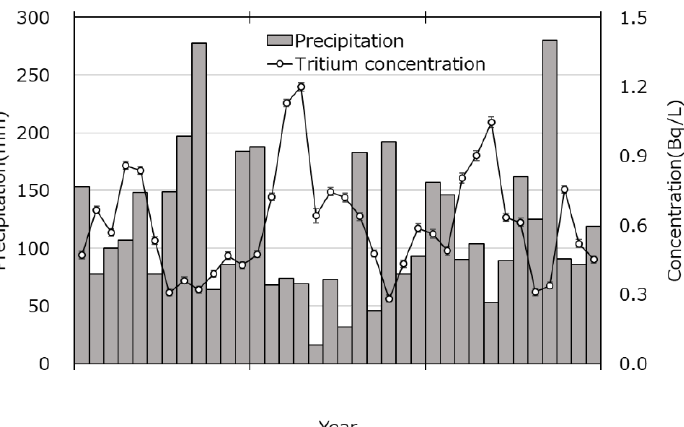
Figure 3. Tritium concentrations in the precipitation and the monthly precipitation amounts at Hirosaki City (2018 to 2020). Table 1. The monthly mean tritium concentrations in the precipitation at Hirosaki City (2018 to 2020).